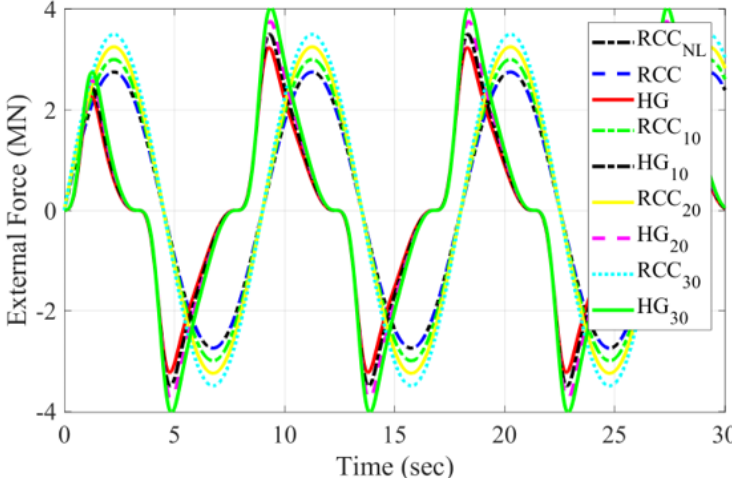
Figure 12. External wave forces for the first 30 s of 100 s duration for all cases, respectively.